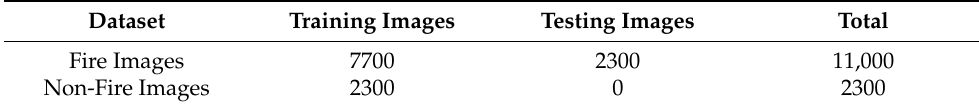
Table 3. Allocation of fire and fire-like images in the dataset.